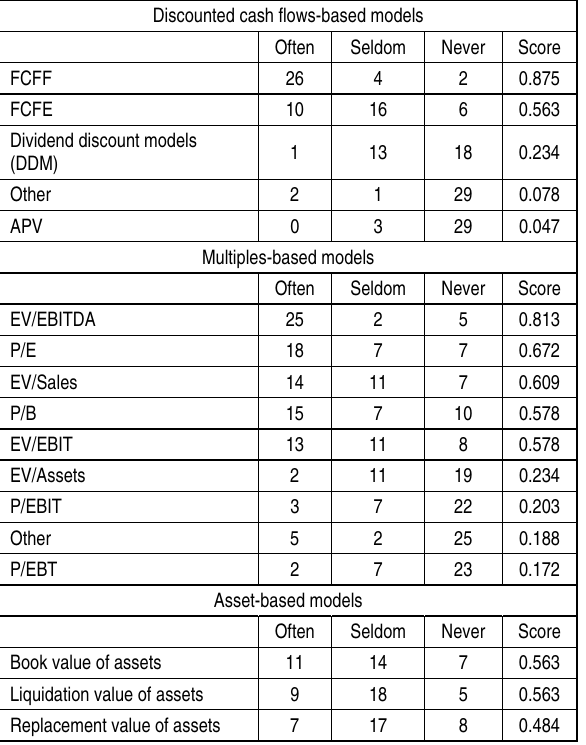
Table 3. Frequency of use of valuation methods by survey respondents with popularity